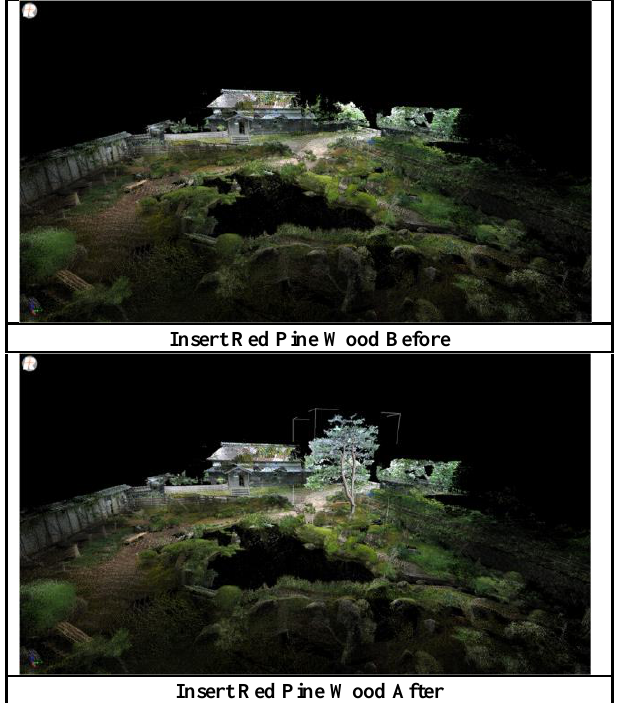
Figure 12. Insert Red Pine Wood on the Saito Family